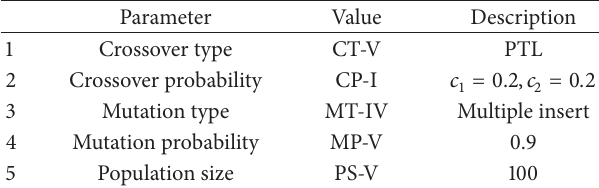
Table 11: Different parameters for the canonical